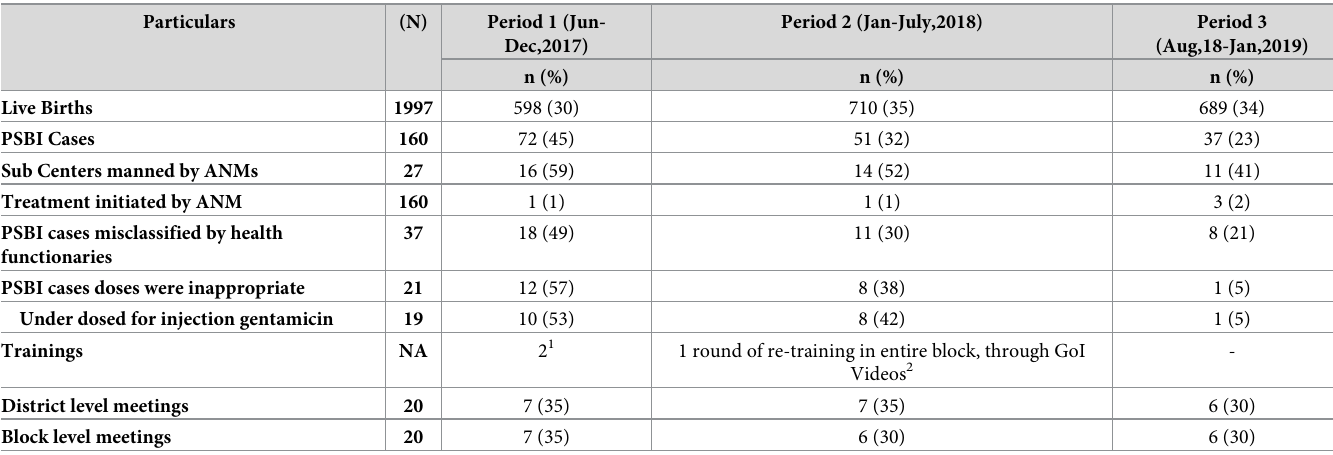
Table 3. Periodic performance over